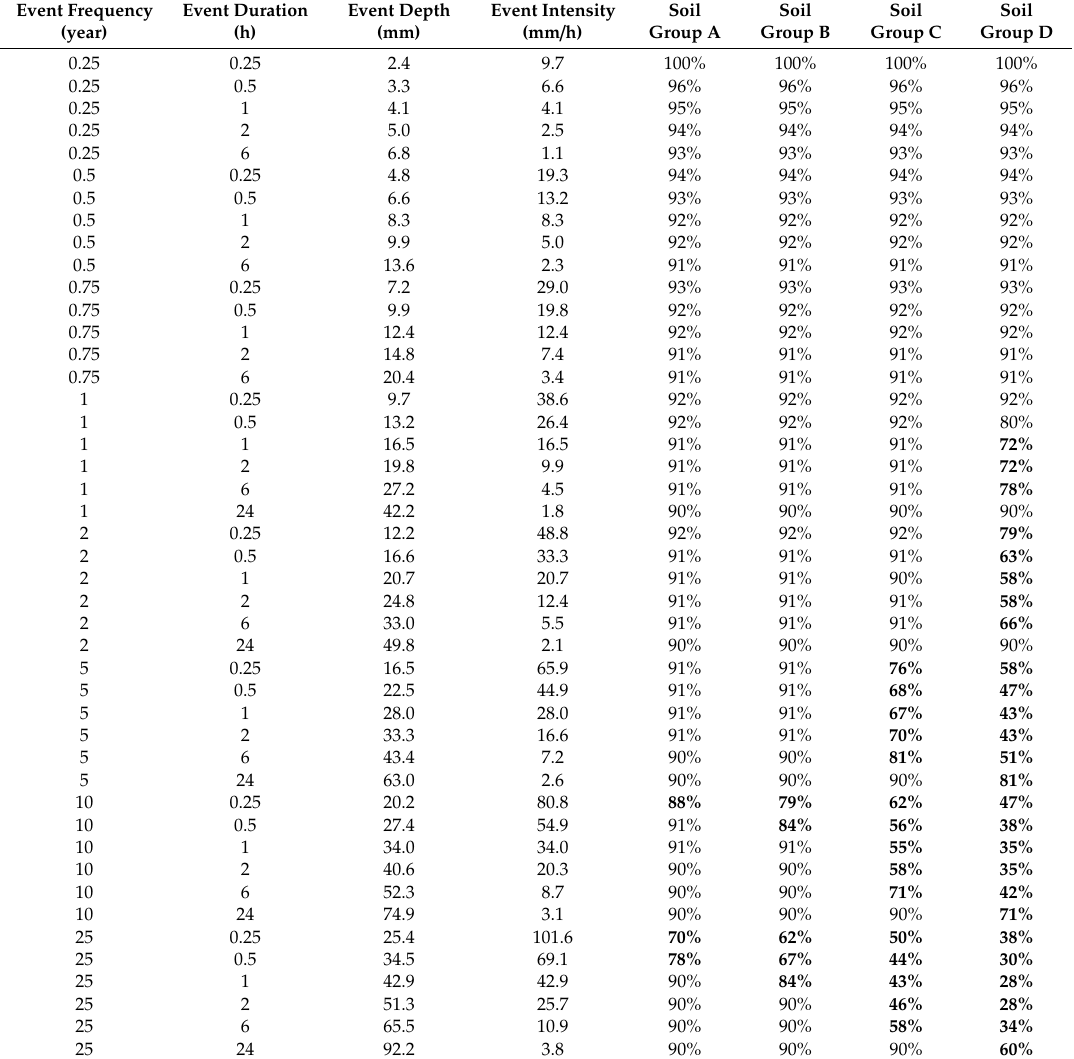
Table 3. %Infiltration results by soil group for all event durations and depths. %Infiltration values < 90% are highlighted in